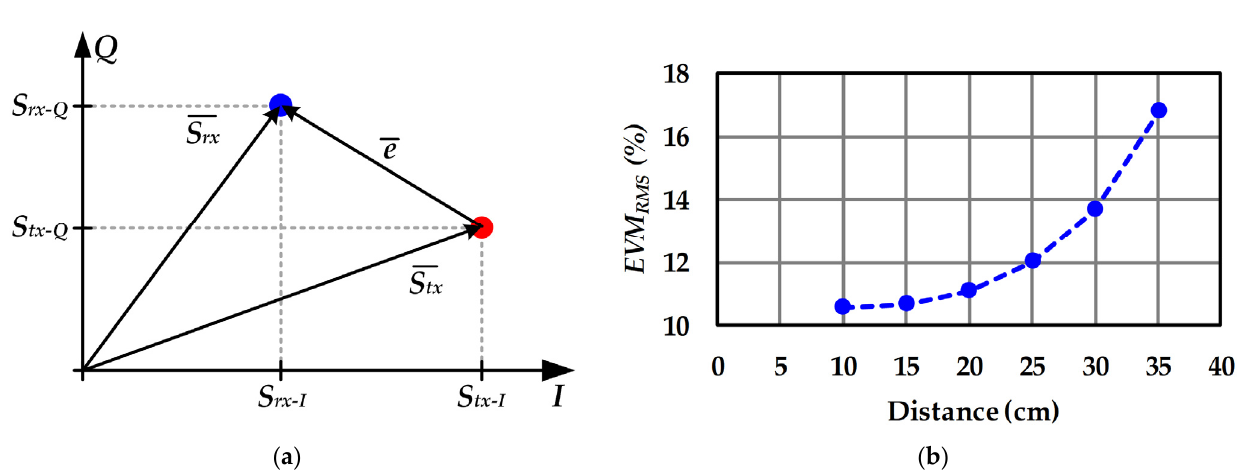
Figure 19. EVM RMS analysis: ( a ) Graphical interpretation. ( b ) Experimental results versus distance.